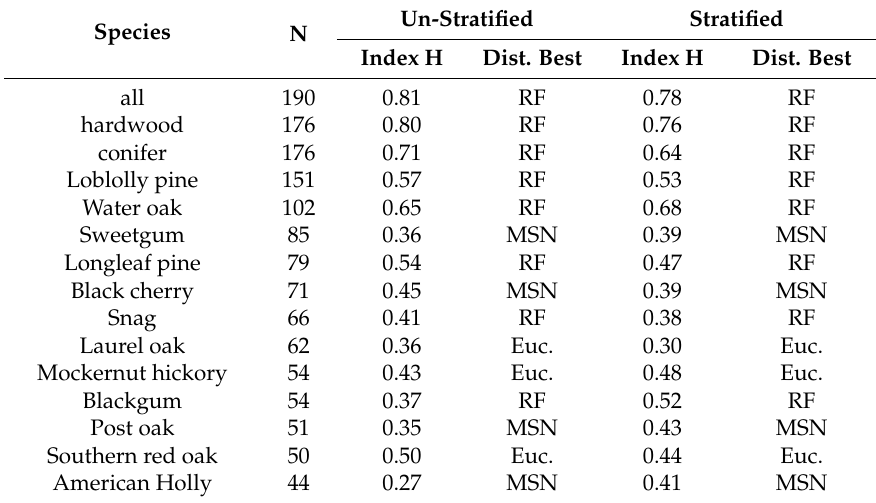
Table 7. Comparison of k-NN (k = 3) density by dbh class with and without stratification for most common species (N = number of plots with species group—it is only by coincidence that both conifers and hardwoods occur on 176 plots